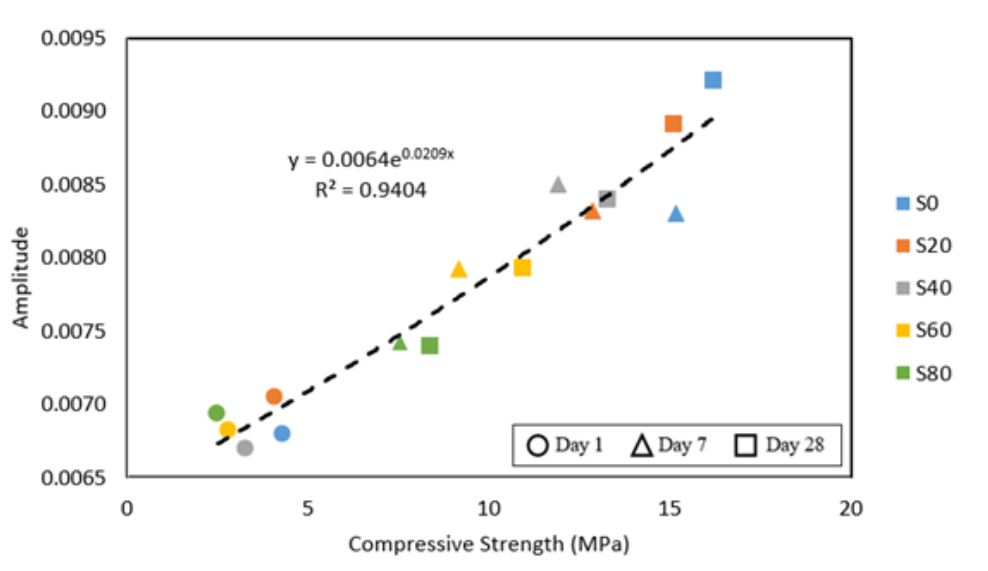
Figure 5. Correlation between P-wave amplitude and the concrete compressive strength of all mix proportions on day-1, day-7 and day-28 maturity ages